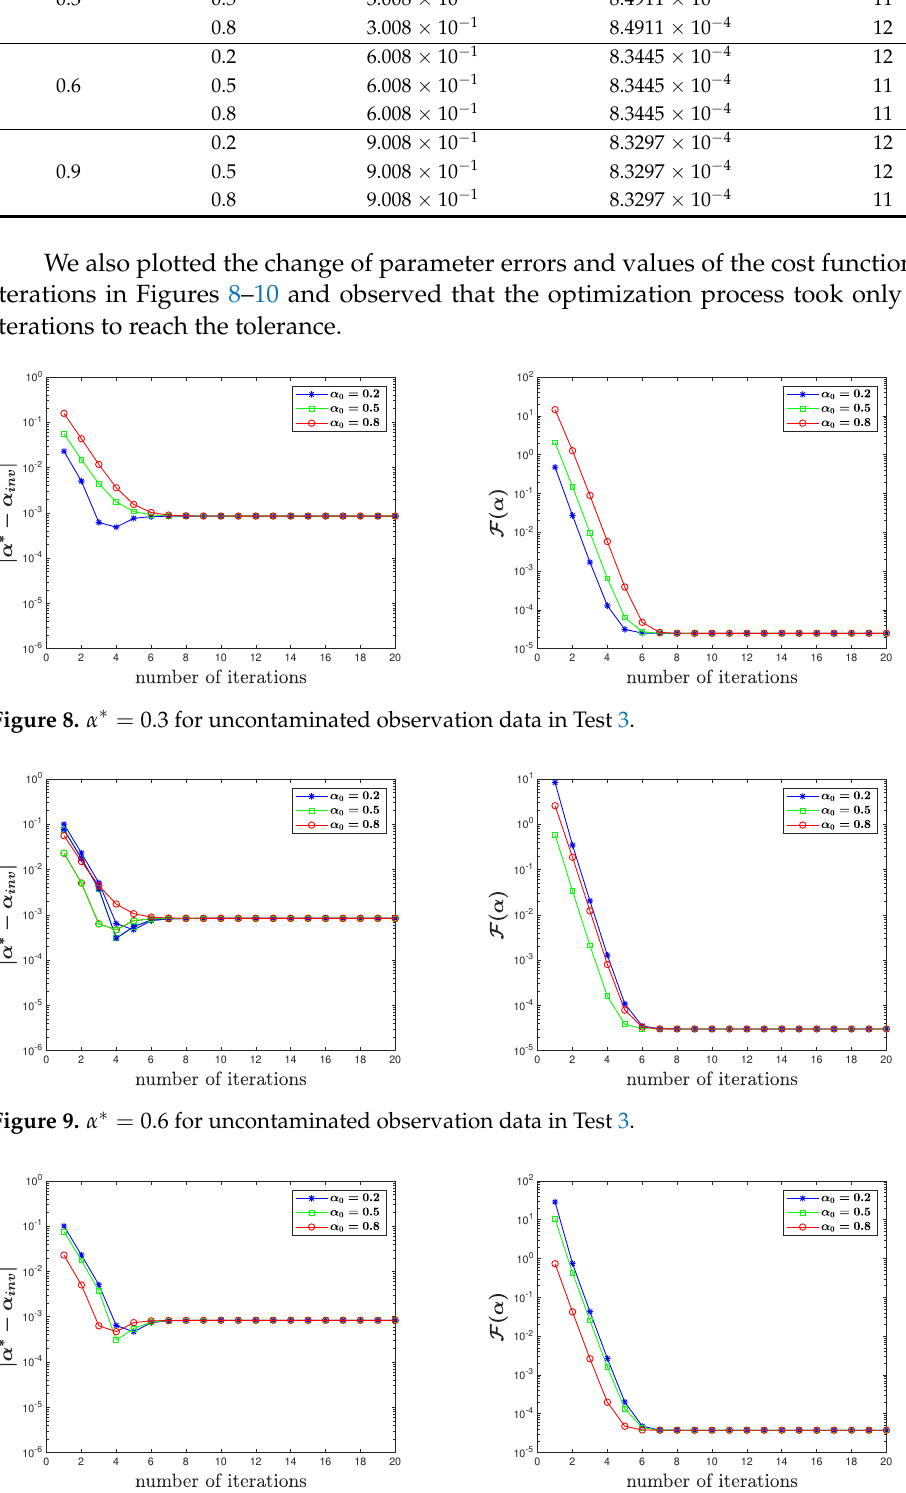
Figure 10. α ∗ = 0.9 for uncontaminated observation data in Test